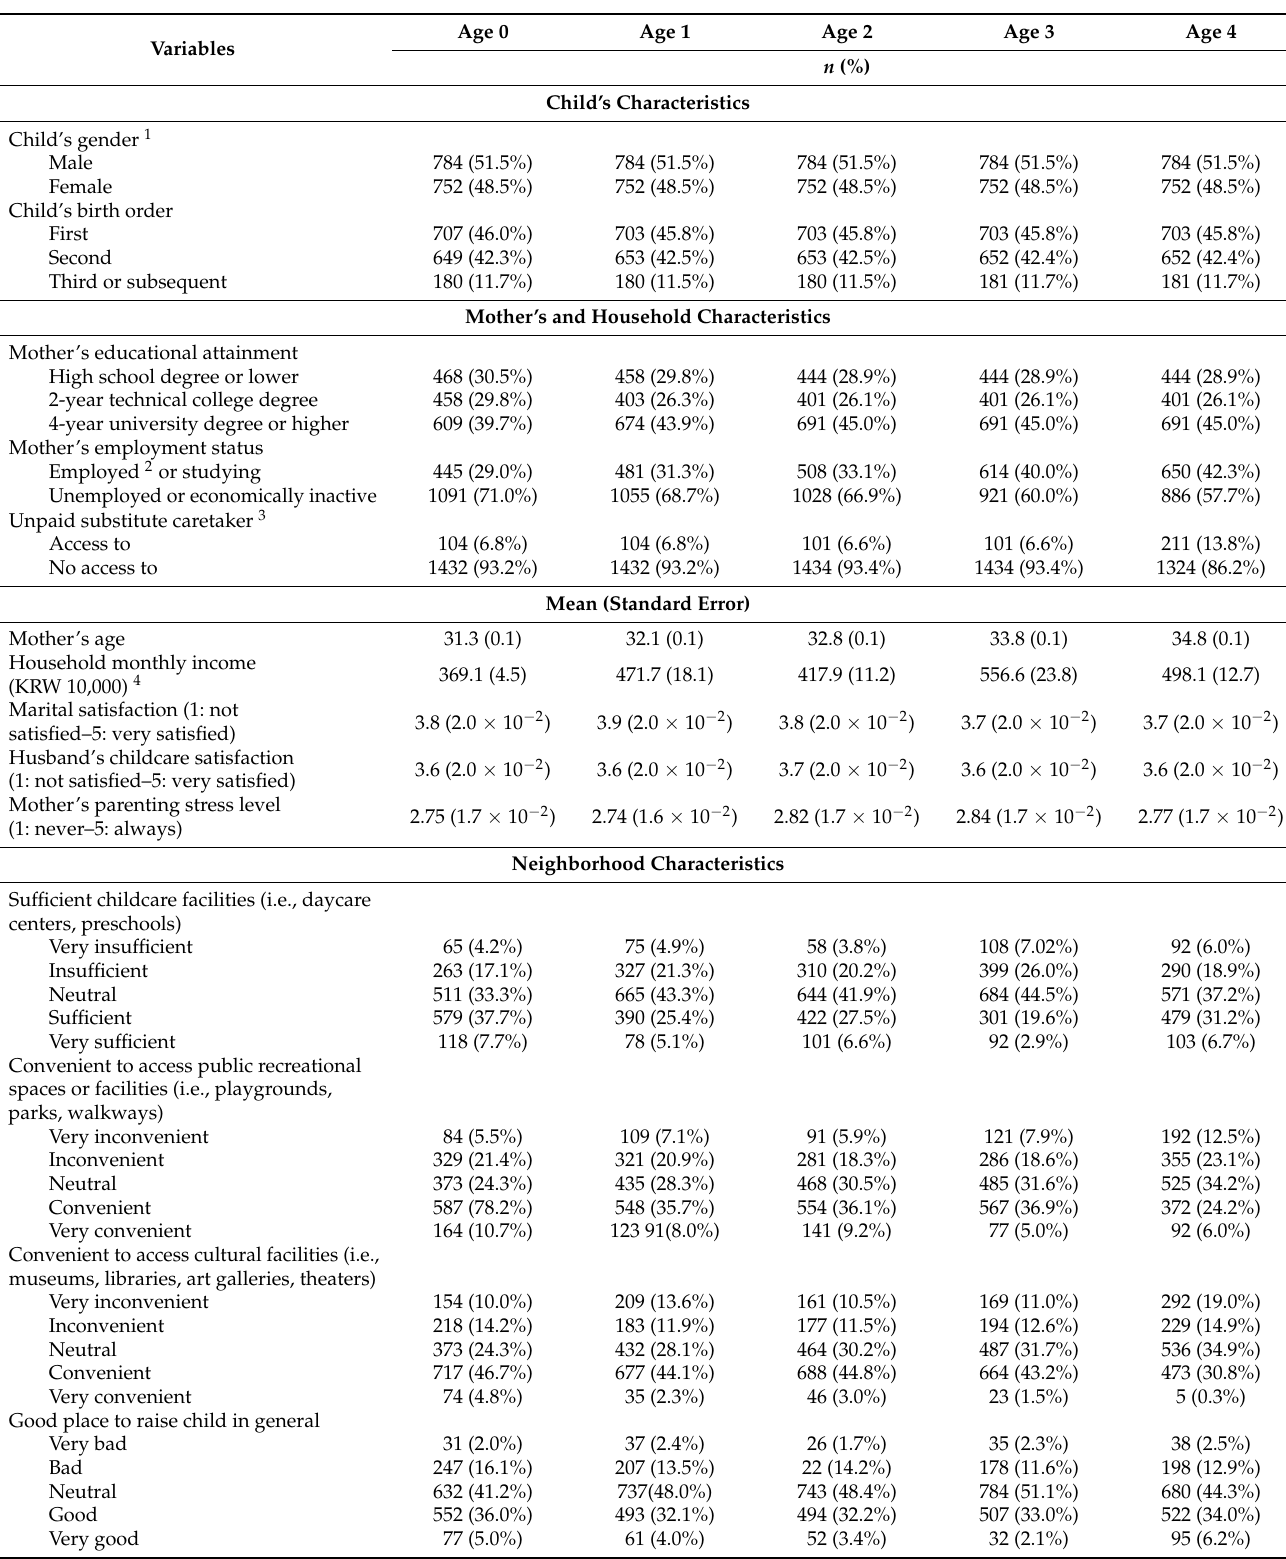
Table 1. Descriptive Statistics for All Study Variables by Child’s Age ( n =